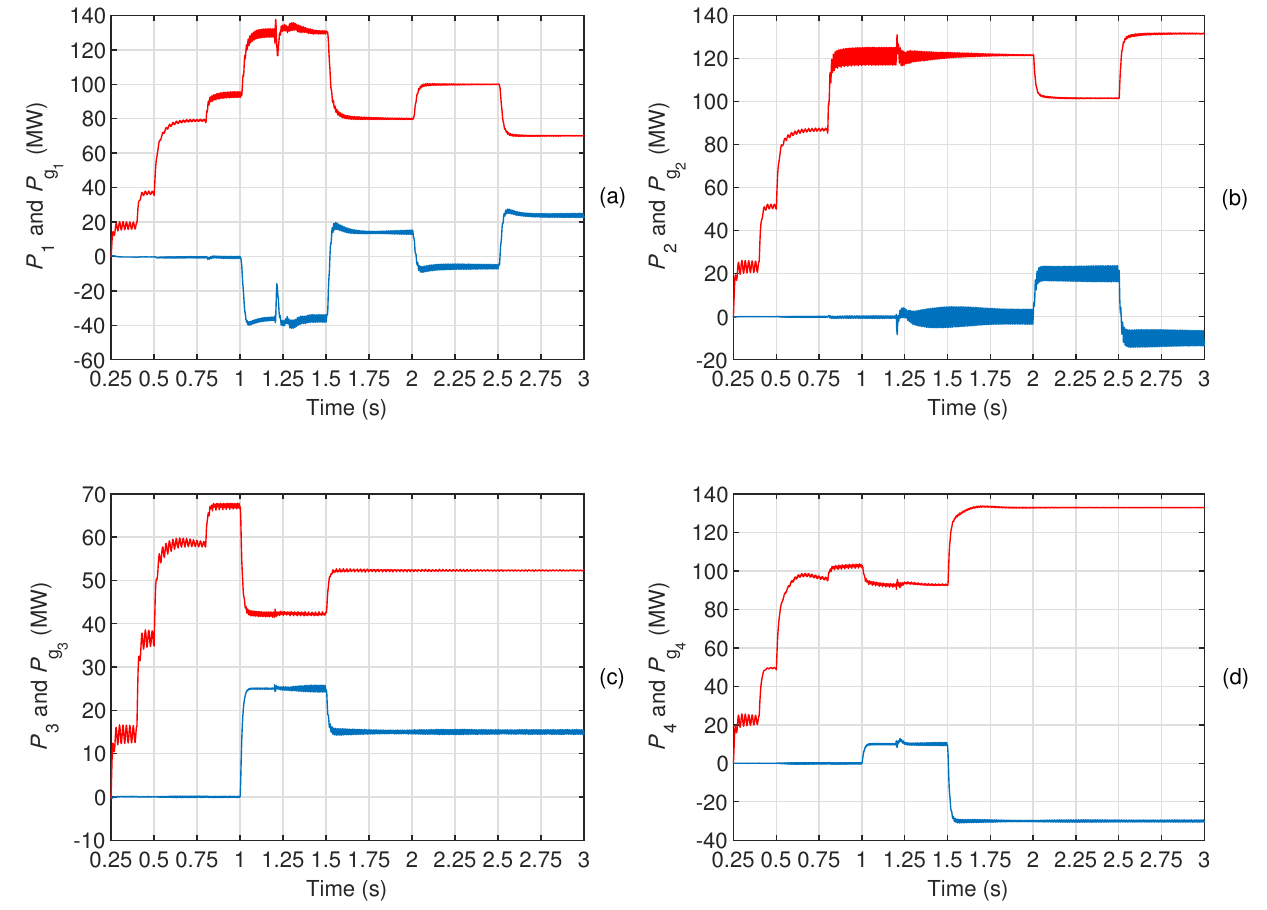
Figure 10. Evolution of the active powers injected/absorbed by each terminal into/from its respective AC grid and the total active power flow in each AC grid: ( a ) active power of terminal 1 p 1 (blue color) and active power of AC grid 1 p g 1 (red color); ( b ) active power of terminal 2 p 2 (blue color) and active power of AC grid 2 p g 2 (red color); ( c ) active power of terminal 3 p 3 (blue color) and active power of AC grid 3 p g 3 (red color); ( d ) active power of terminal 4 p 4 (blue color) and active power of AC grid 4 p g 4 (red color).